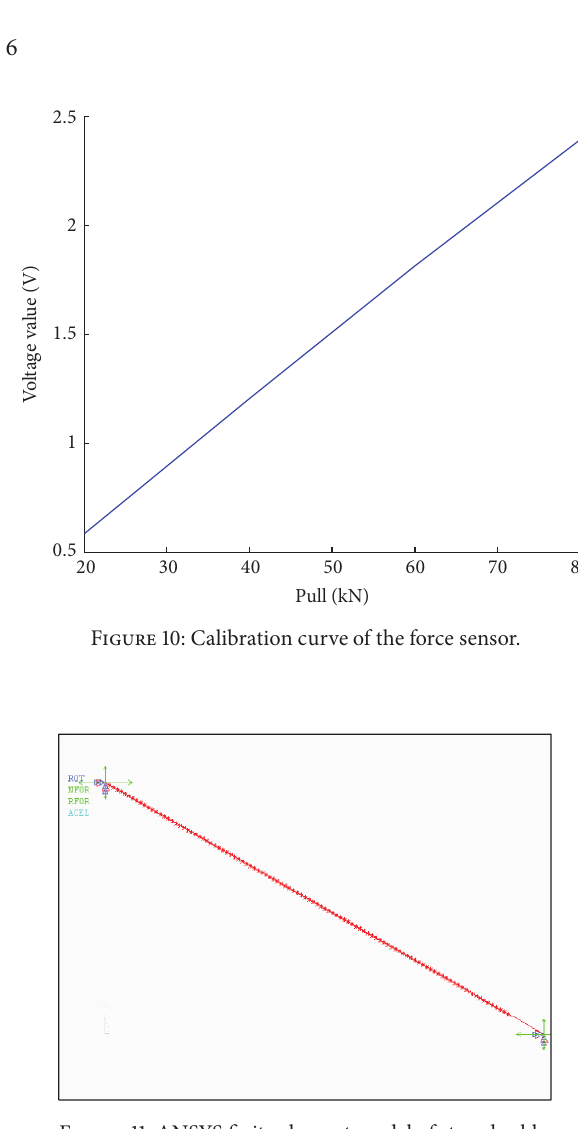
Figure 11: ANSYS finite element model of stayed cable.